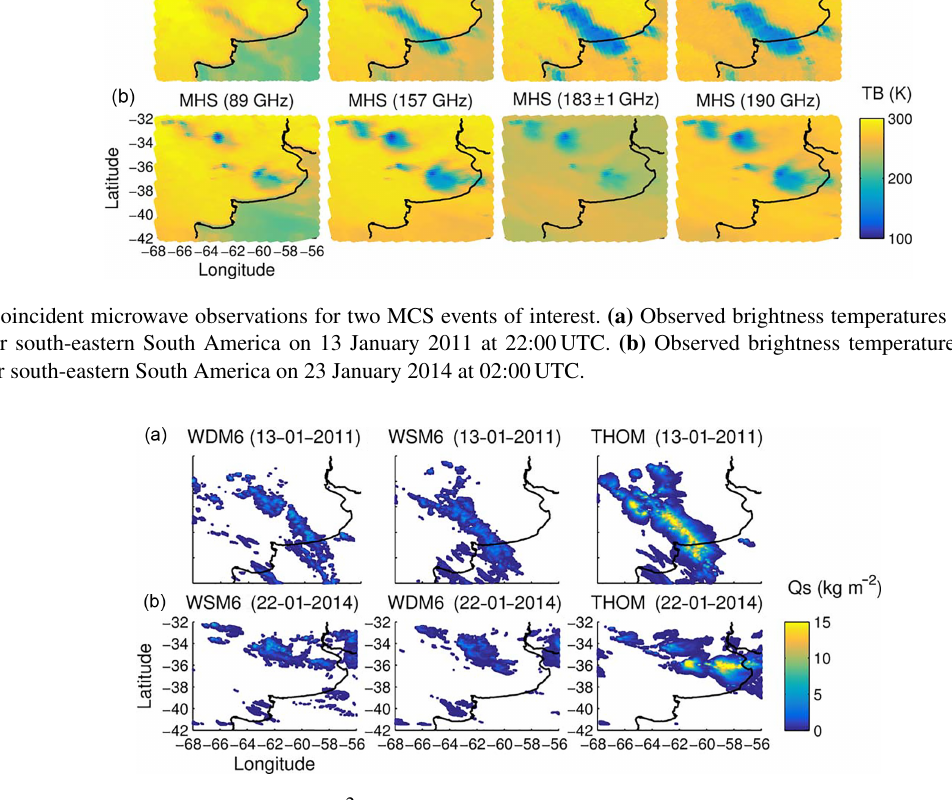
Figure 17. The integrated column content in kgm − 2 for snow as simulated by the WRF microphysics options WSM6, WDM6 and THOM, on 13 January 2011 at 22:00UTC (a) and on 23 January 2014 at 02:00UTC (b) , with a 0.05kgm − 2 minimum